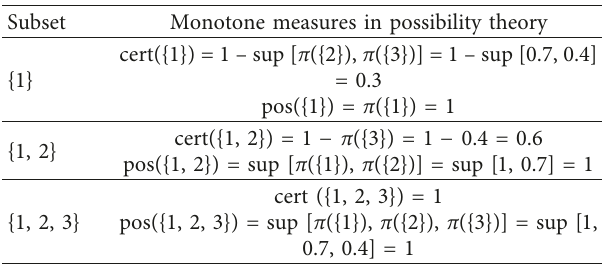
Table 13: The calculated monotone measures in possibility